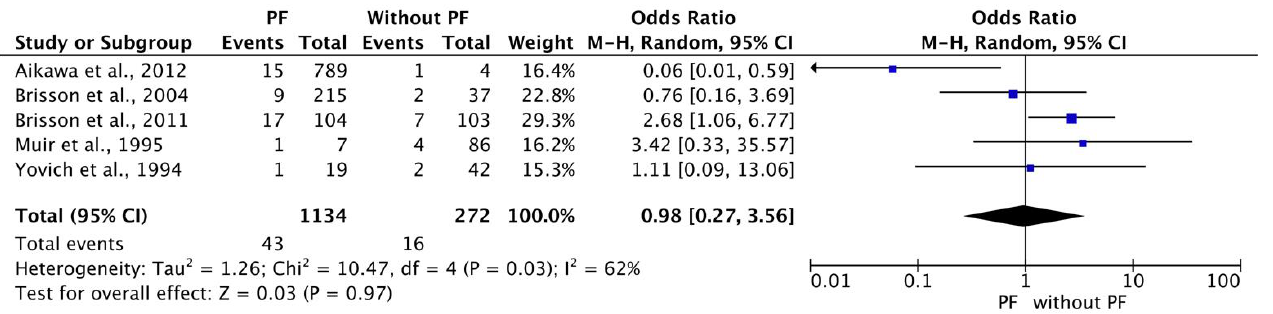
Figure 6. Meta-analysis for recurrence ratio (with prophylactic fenestrations; without prophylactic fenestration) [19,21,24,104,105].